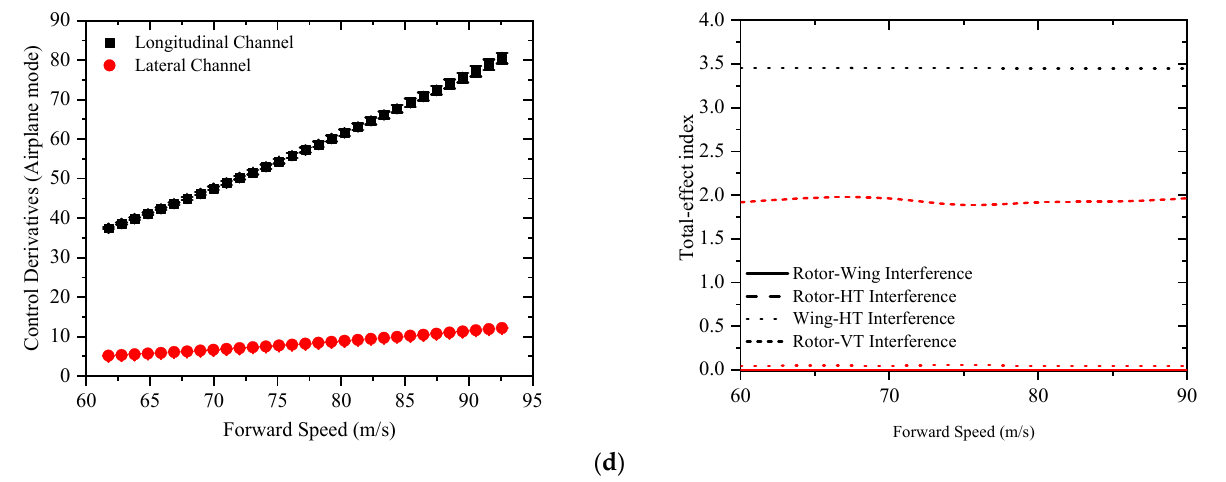
Figure 5. On-axis control derivative results. ( a ) Helicopter mode; ( b ) Conversion mode (30 Deg); ( c ) Conversion mode (60 Deg); ( d ) Aeroplane mode.